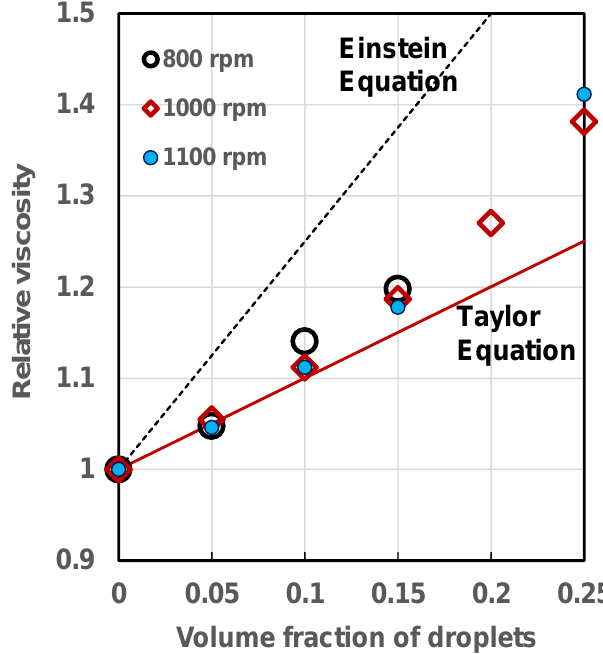
Figure 17. Comparison between experimental viscosity data and theoretical predictions for emulsions.